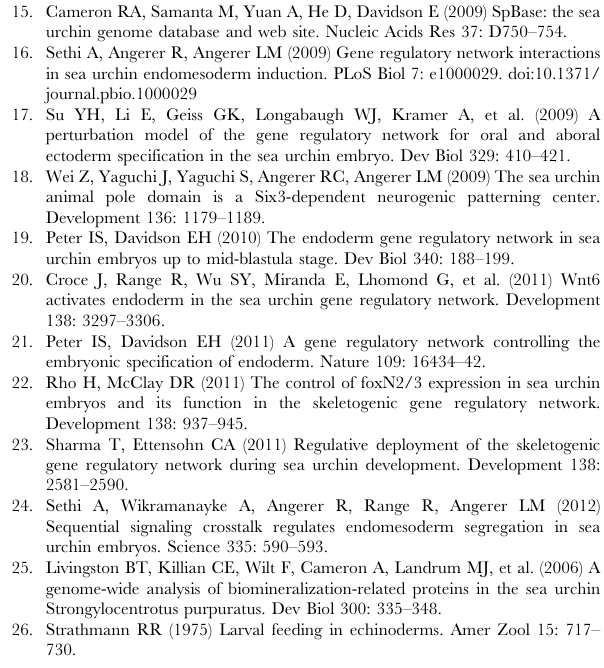
Table S3 The relative weightings of each skeletal measure in the first three principle components of skeletal variation. These three axes explain 55.1%, 20.4%, and 13.4% of the total between culture variation in skeletal morphology. Table S4 Male, female, and interaction contributions to between family variation in the principle components of skeletal variation. ** indicates p , 0.01 using a standard likelihood ratio test. Table S5 Single gene correlations with morphology. This table provides the full set of correlations between each gene at each time point and the first three principal components of larval skeletal variation, as measured at time point 7. Table S6 The weights of each skeletal measure’s contribution to the six vectors summarizing skeletal variation produced by the two block partial least- squares analysis. Table S7 Each of the six pairs of vector found by the two block partial least-squares analysis contributes differ- ent amounts to the total correlation between gene expression and skeletal variation. The relative weighting of each of the six pairs of vectors are described by the eigenvalues given in this table. Table S8 The top 10% of gene expression contributions to the first 2B-PLS axis. The column ‘‘Gene_Cluster_Time’’ gives the gene name followed by the cluster number (see Text S1 – ‘‘Gene expression DASL processing’’) followed by the time point at which the expression measurements were taken.